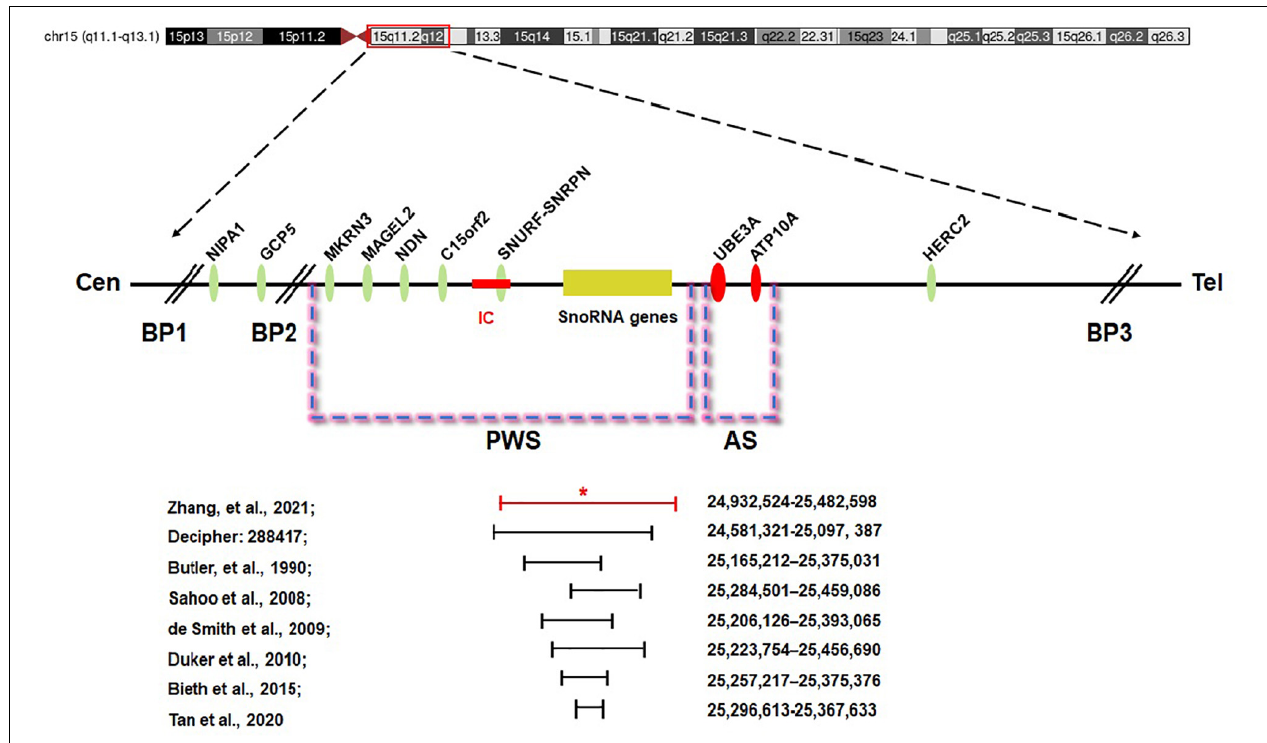
FIGURE 5 | Prader–Willi syndrome (PWS) and Angelman syndrome (AS) domain in proximal chromosome 15q11-q13. The positions of genes (oval) in PWS, AS, and the IC are illustrated. CEN, centromere; Tel, telomere; IC, PWS imprinting center (red rectangle); BP, breakpoint; *the breakpoint of the